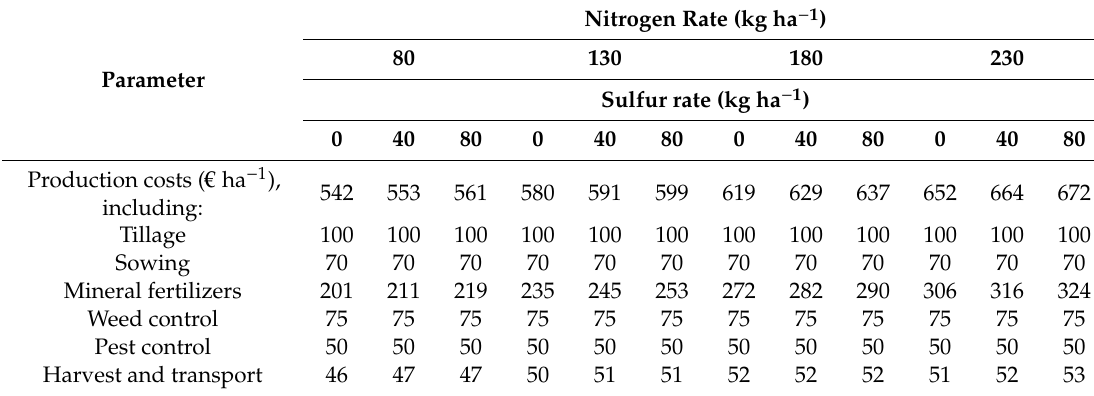
Table 7. Production costs of the open-pollinated cultivar of winter oilseed rape (cv. Adriana), across years.